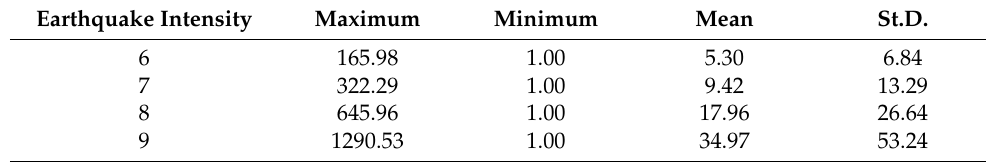
Table 4. Statistical values of amplification factor for different earthquake intensities.